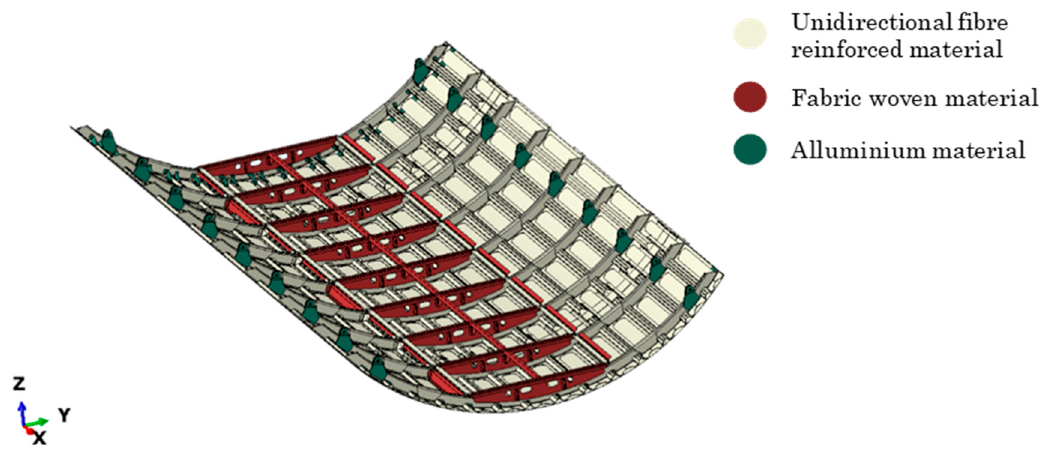
Figure 4. Sub-cargo components and materials.